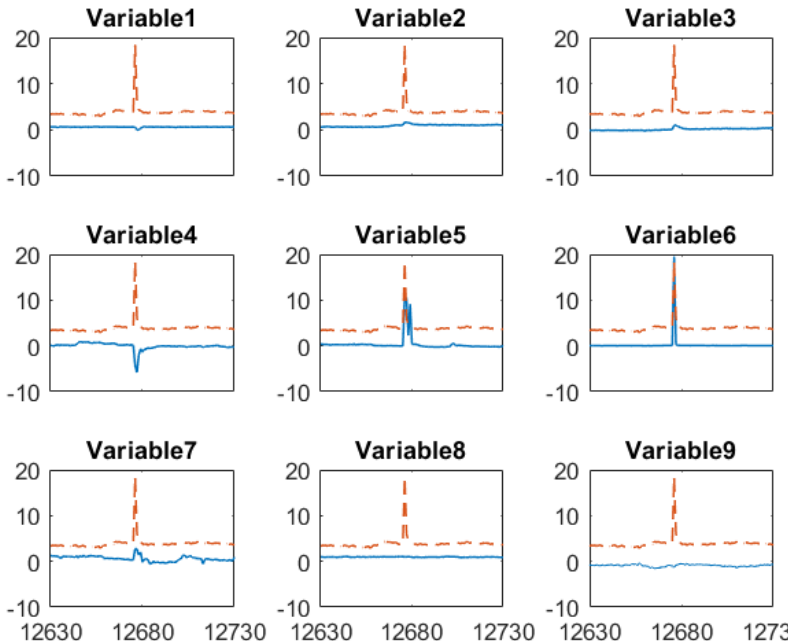
Figure 10. Mean-centered and scaled input variables (--) of the software sensor and soft sensor predicted impurity ( ─ ) around when the false alarm by PLS soft sensor occurs.